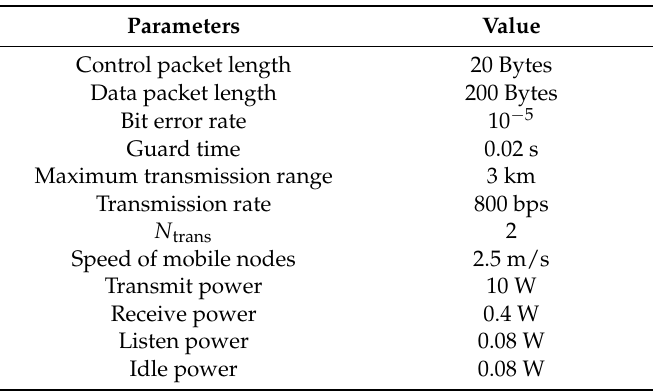
Table 1. Simulation